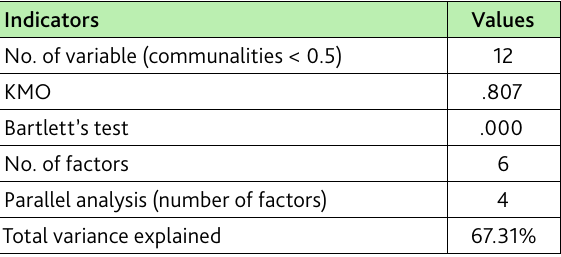
Table 3. PCA indicators for Austria